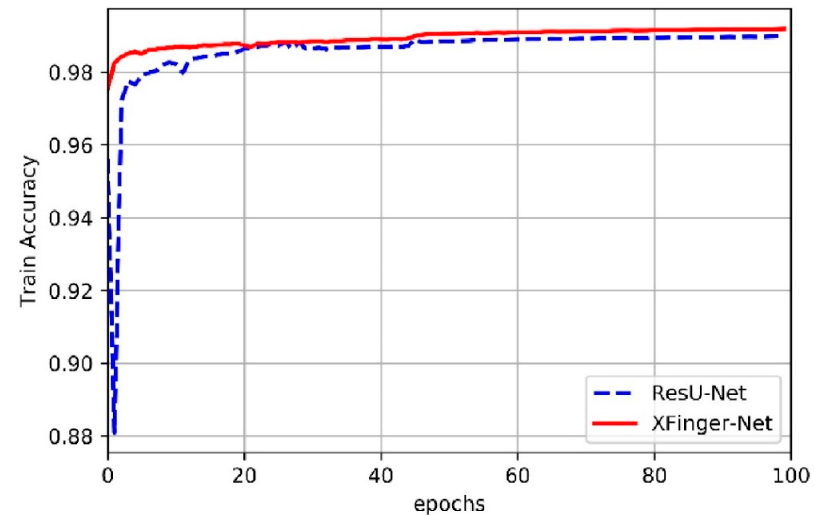
Figure 6. Train accuracy of XFinger-Net and ResU-net with epoch during training.